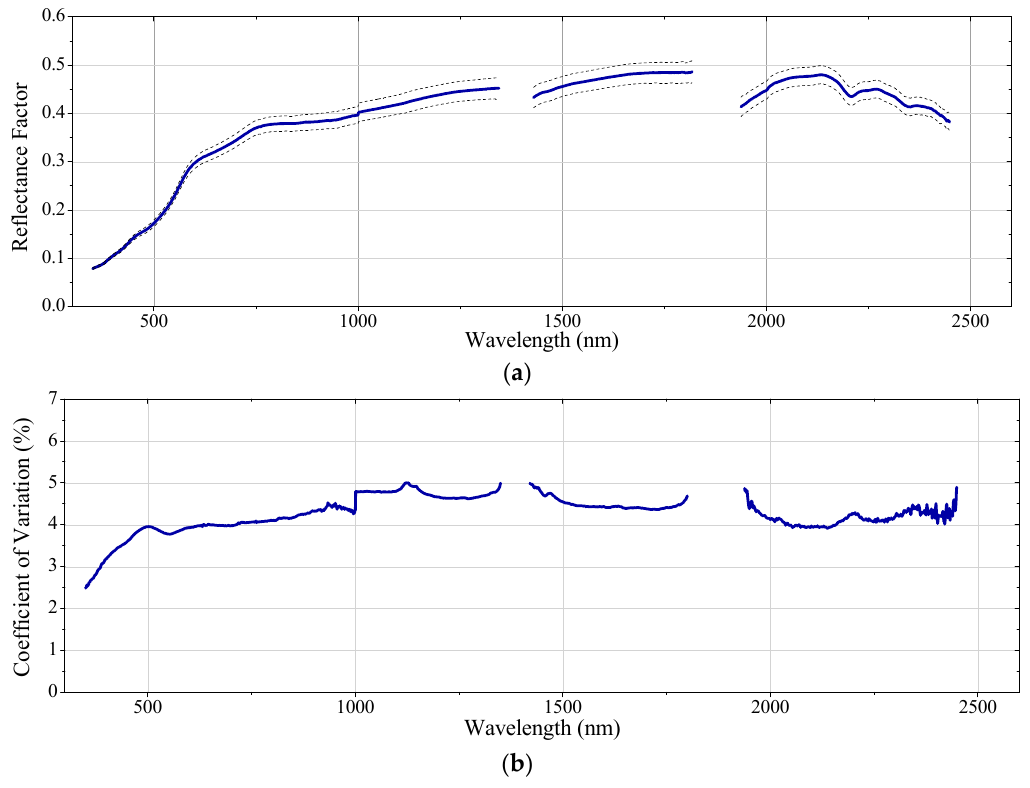
Figure 7. ( a ) Spectral reflectance results of 160 × 300 m site at Algodones Dunes on 9 March 2015. The solid line shows the average reflectance and the dashed line shows the maximum and minimum variation of the average (±1 σ ); ( b ) Surface Coefficient of Variation in percentage.